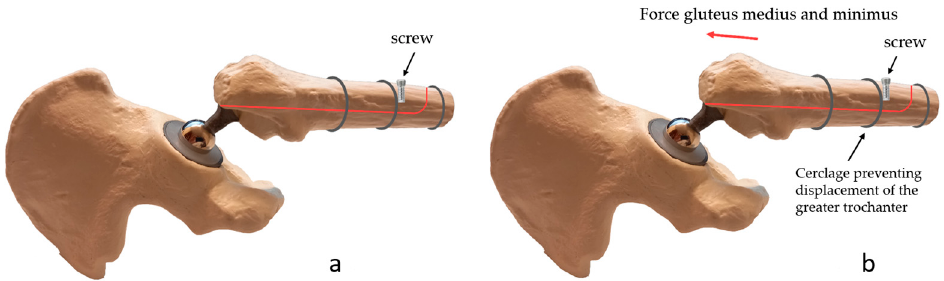
Figure 4. ( a ). Novel surgical technique: a monocortical periprosthetic screw is placed on the trochanter fragment immediately distal to the distal cable cerclage fixing the osteotomy. ( b ). Biomechanical principles that prevent trochanteric escape: The force exerted by the gluteus medius and minimus muscles pulls the trochanter fragment cranially. The screw placed on the trochanter fragment is pulled cranially with the trochanter fragment. The contact of the screw with the distal cerclage prevents the screw and thus the trochanter fragment from moving cranially.